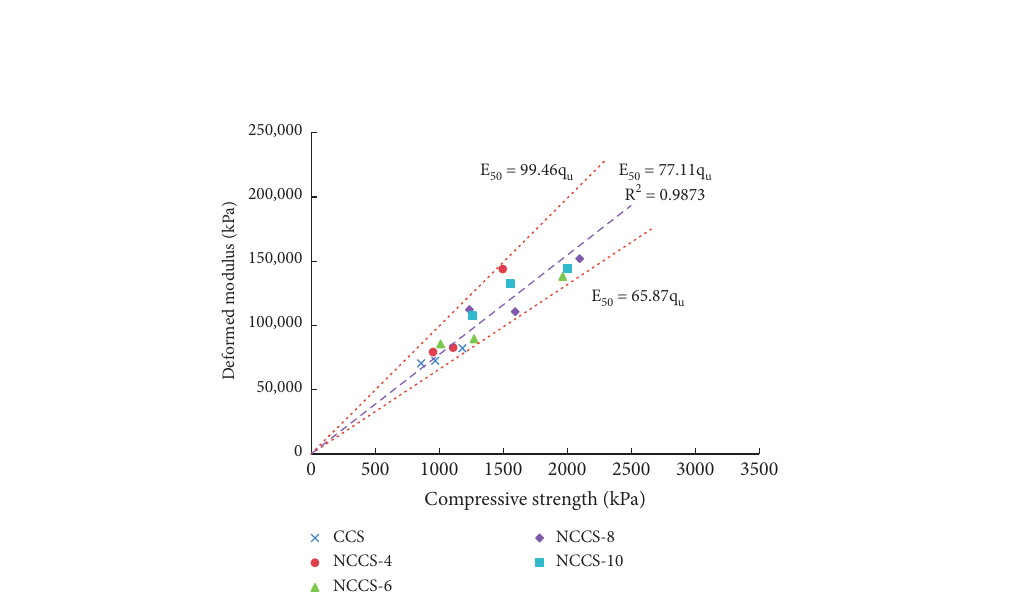
Figure 12: The relationship between the compressive strength and the deformed